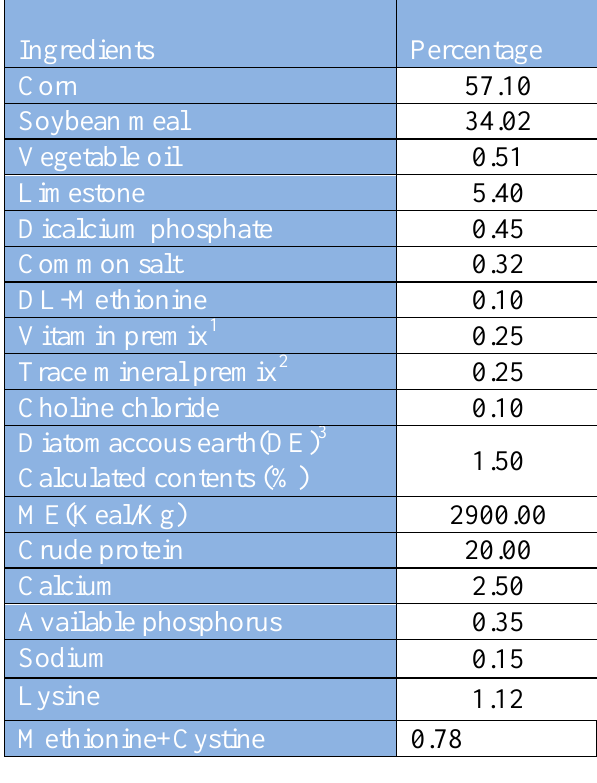
Table, 1: The composition of experimental